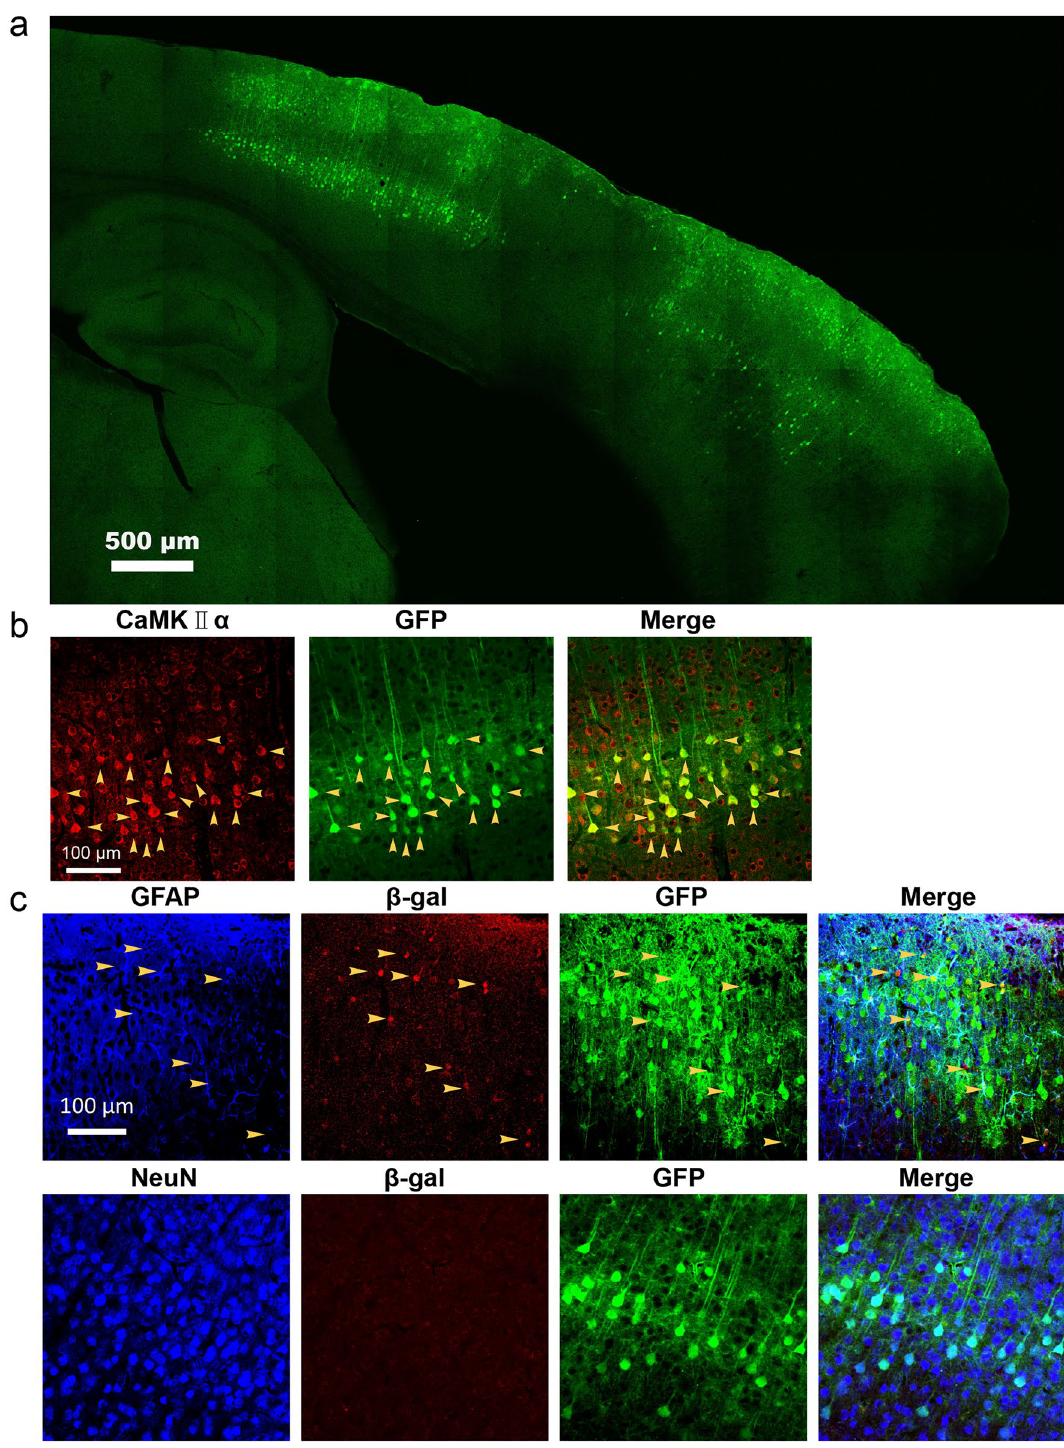
Figure 2. EGFP distribution in the cortex 10 days after injecting AAV. ( a ) The microscopic photo with low magnification shows EGFP+ cells in cerebral cortex. ( b ) Immunostaining of CaMK II α and EGFP to discriminate the subtype of EGFP+ neurons. Yellow arrows, double positive cells. ( c ) Immunostaining of GFAP/ NeuN, β-gal and EGFP to discriminate cells expressing EGFP or receiving transported EGFP. Yellow arrows, triple positive